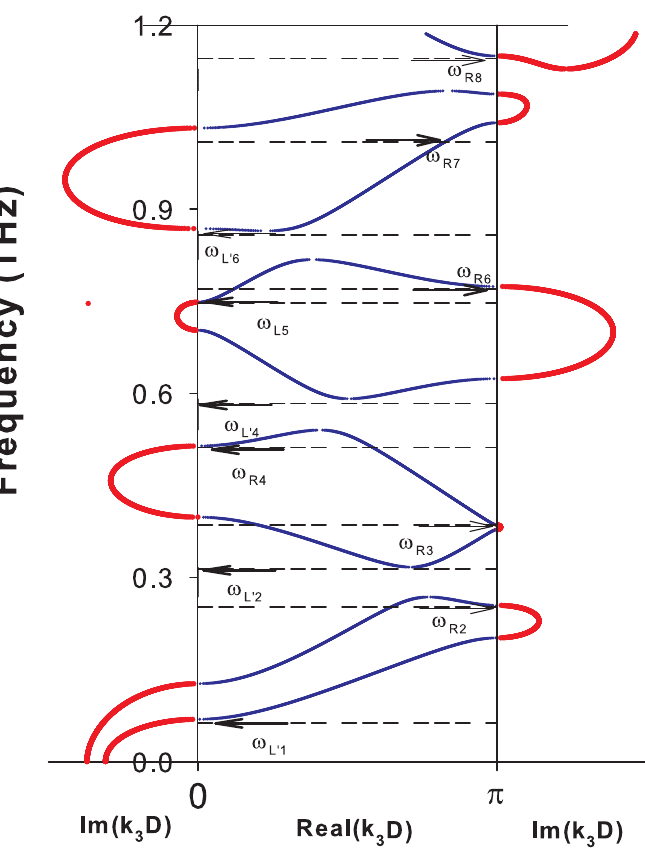
Figure 3. Same as in Figure 2, but for k // D = 1. Blue and red curves correspond to real and imaginary parts of the wavevector k 3 inside the Brillouin zone, respectively. The horizontal arrows indicate the frequency positions of the surface localized ( L i ) and resonant ( R i )